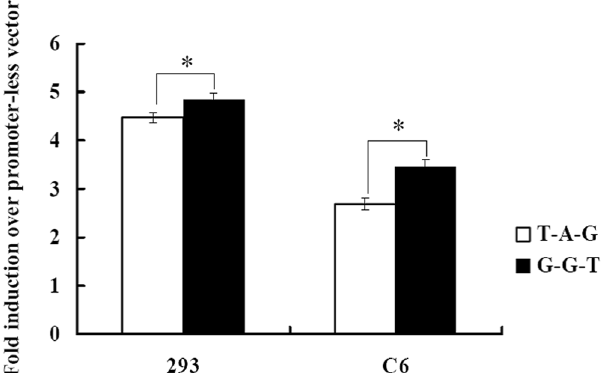
Figure 2. Regulatory effects of the haplotypes constructed from rs4836316, rs2194079 and rs4836317 on the transcriptional activity. The transcriptional activity was decreased when the risk haplotype T-A-G in 293 and C6 cell lines. Bars are presented as fold-induction compared with promoter less vector. Error bars represent standard error of mean (SEM) ( n = 5). * P < 0.05.